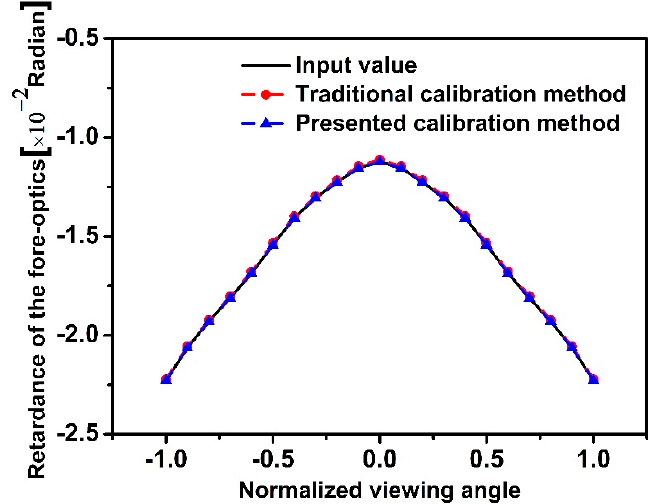
Figure 7. Input values and calibration results of ϕ 1 ( σ , θ )